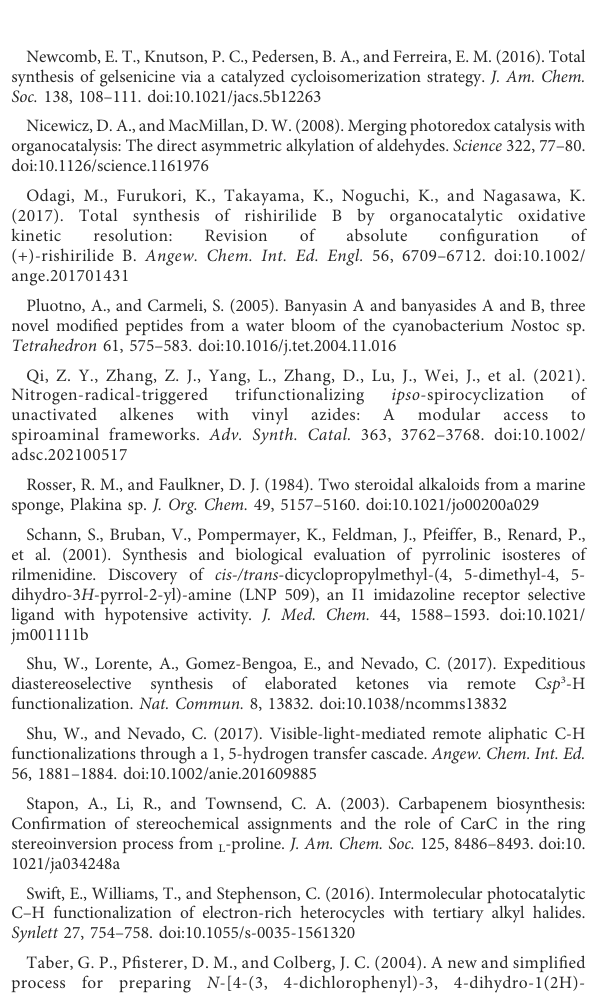
Taber, G. P., P fi sterer, D. M., and Colberg, J. C. (2004). A new and simpli fi ed process for preparing N -[4-(3, 4-dichlorophenyl)-3,